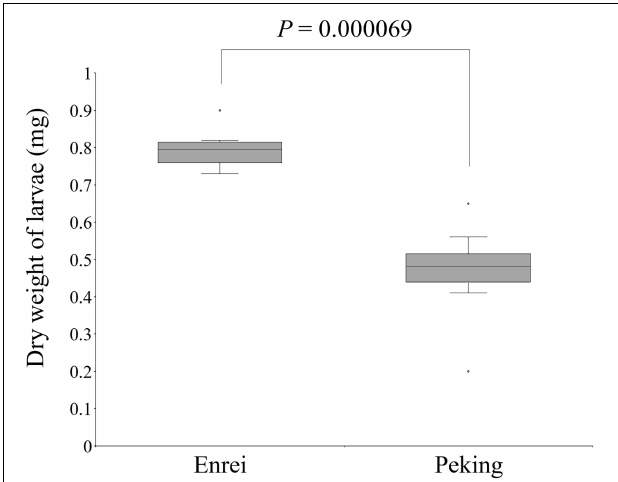
FIGURE 1 | Significant dry weight differences of common cutworm larvae fed on leaves of Enrei and Peking ( n = 8; Welch’s t